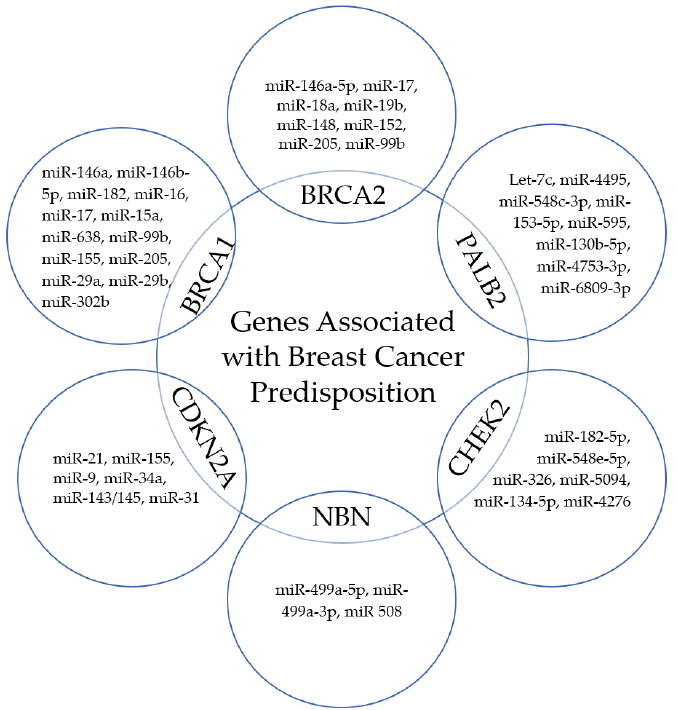
Figure 3. Selected miRs correlated with the expression and function of breast cancer predisposition genes.